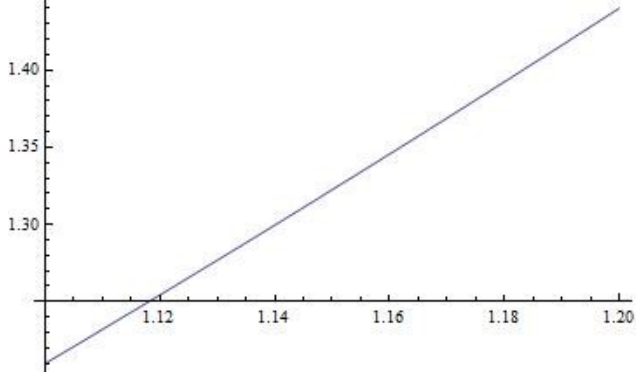
Fig. 4 Graph of the solution using AIM for the interval [ 1 . 1 , 1 . 2 ) .